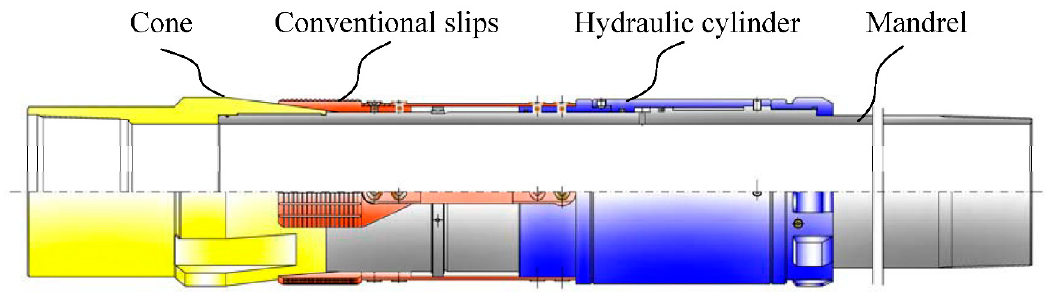
Figure 1. Conventional liner hanger.